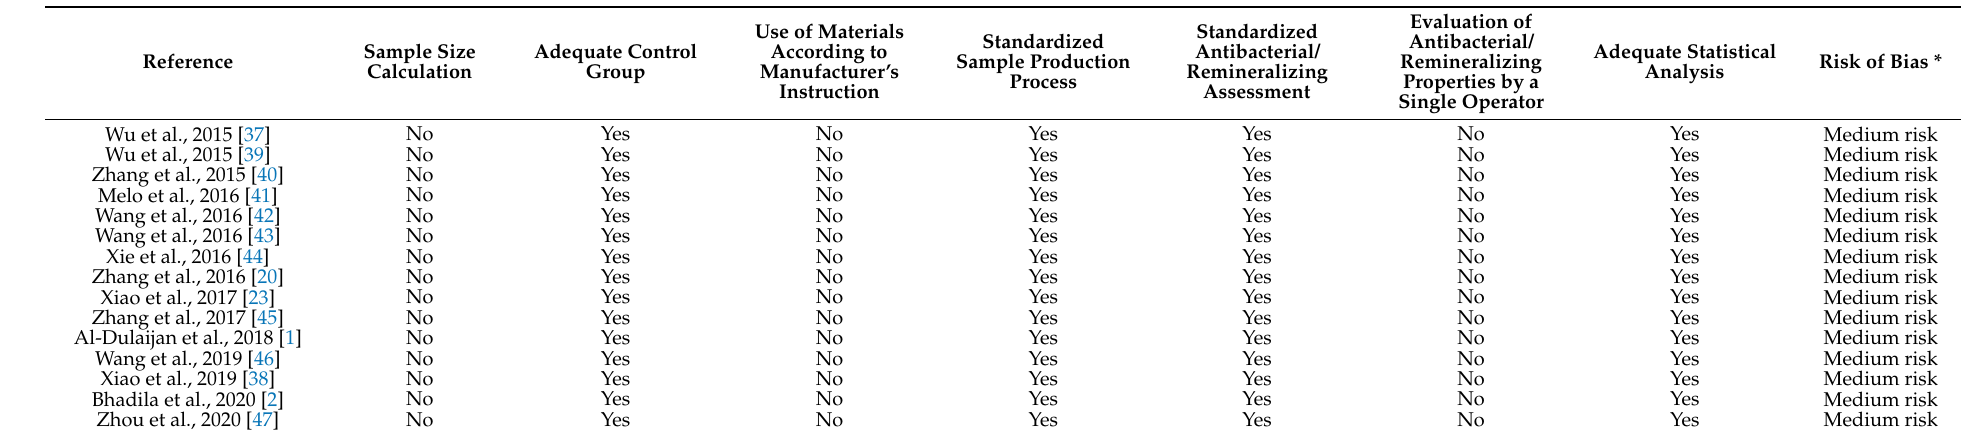
Table 3. Risk of bias among the included